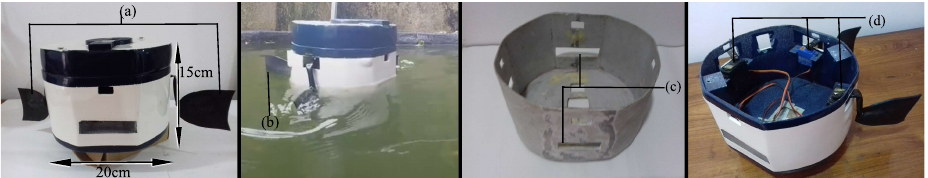
Figure 1. Basic appearance of the robot. From left to right. (1) Final Design of the robotic fish. ( a ) Robot fish fins. (2) Robot floating in a fish tank, ( b ) Tail of the robot. (3,4) Rigid robotic fish body and internal structure of the robotic fish. ( c ) Two acrylic boards are used for the front, and bottom to place cameras inside the robot. Front: IR camera to capture the fish behaviors around the water surface. Bottom: GoPro camera for capturing fish behaviors at the bottom area of the fish tank. ( d ) Servo motor placements for robot